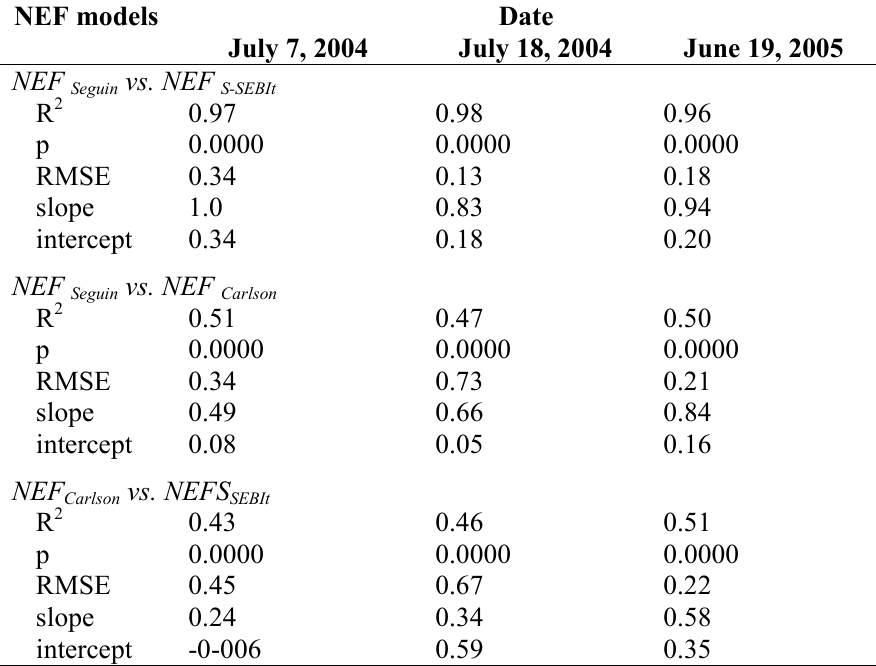
Table 1. Comparison of NEF (non-evaporative fraction) obtained with NEF NEF models on the three dates using all the pixels in each image. RMSE is the root mean square S-SEBIt error and p is the probability level associated with the